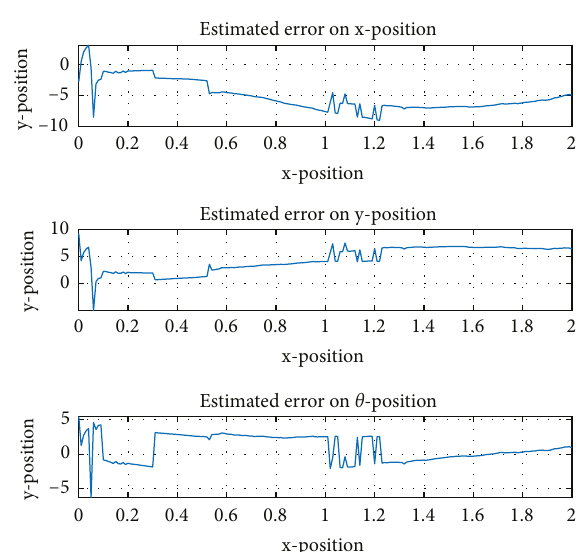
Figure 10: The induced estimation error from the EKF (two landmarks and non-Gaussian noise).